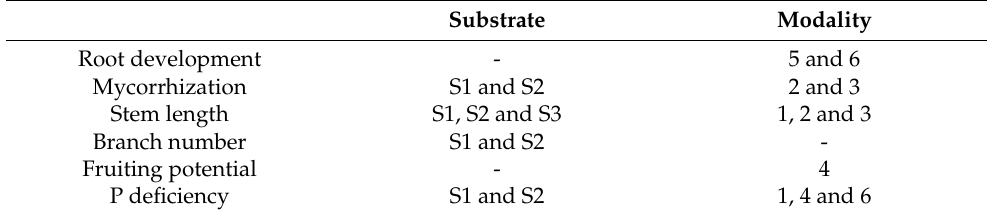
Table 6. Summary of substrates and treatments with a positive effect or no effect (-) on plants: root development, mycorrhization rates; stem length, branch number, fruiting potential and P